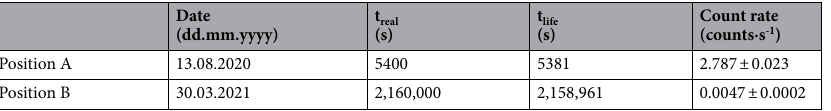
isotopic abundances reported in 47,49 and the nuclide masses listed in 50 . This (linear) relation, together with the exponential mass discrimination factors for Er, allowed for accurate mass discrimination corrections of the 154 Dy/ 161 Dy ratio in the Dy master solution. As a final result from the average of six analyses (see Table S6), the 154 Dy/ 161 Dy ratio was determined as (0.277317 ± 0.000085). The concentration of 154 Dy in the Dy master solution